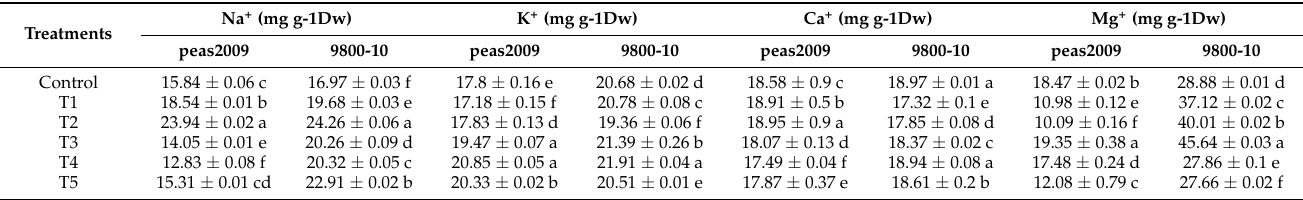
Table 3. Influence of K. rhizophilla on Na + , K + , Ca ++ , and Mg ++ ions in shoots under NaCl stress. Each treatment is presented as mean values of triplicate data ( n = 3) with standard error (S.E). C represents uninoculated control, T1 (75 mM NaCl), T2 (150 mM NaCl), T3 (inoculated with K. rhizophila ), T4 (75 mM NaCl + K. rhizophila ), and T5 (150 mM NaCl + K. rhizophila ). Different letters on means of treatment show significant difference at p <